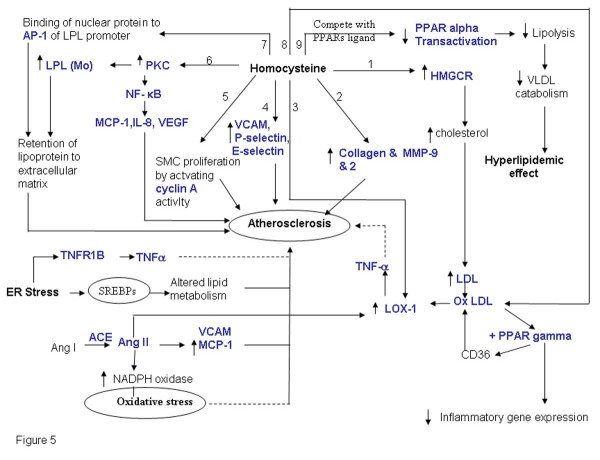
Elevated Homocysteine is associated with atherosclerosis. Elevated level of homocysteine affects the cholesterol biosynthesis (branch 1), expression of extracellular matrix proteins (branch 2), enhance endothelial LOX-1 gene expression and TNFα release upon oxLDL stimulation (branch 3,branch 8), affect the expression of cell adhesion molecule (branch 4), enhance SMC proliferation by increasing cyclin A activity (branch 5), induce the expression of LPL both at the transcription and translation level presumably via PKC activation (branch 6,7) that modulates inflammatory gene response in endothelial cells. Elevated level of homocysteine also down regulate the expression of PPARs (Figure 6, branch 9). The genes marked in blue have been identified by literature based searches as mentioned in the methods section. The solid and dotted lines indicate direct and indirect (multi step) interaction/ conversion respectively.